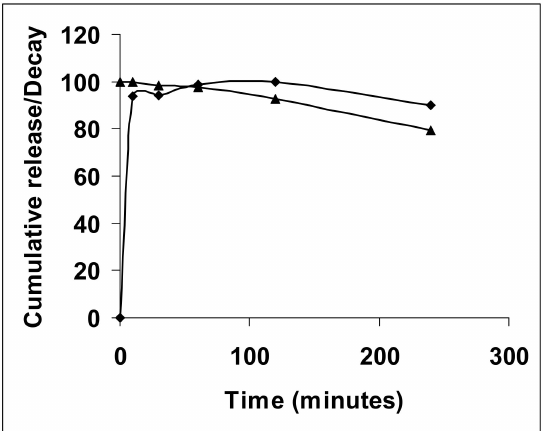
Figure 1. Rate of NAC-SNO release from nanoparticles; NAC-SNO-nps were dispersed in PBS, pH 7.4 at room temperature. The amount of NAC-SNO released (diamond) was determined from the absorbance of the bu ff er at 335 nm. The rate of decay of NAC-SNO (triangle) at room temperature is also shown.